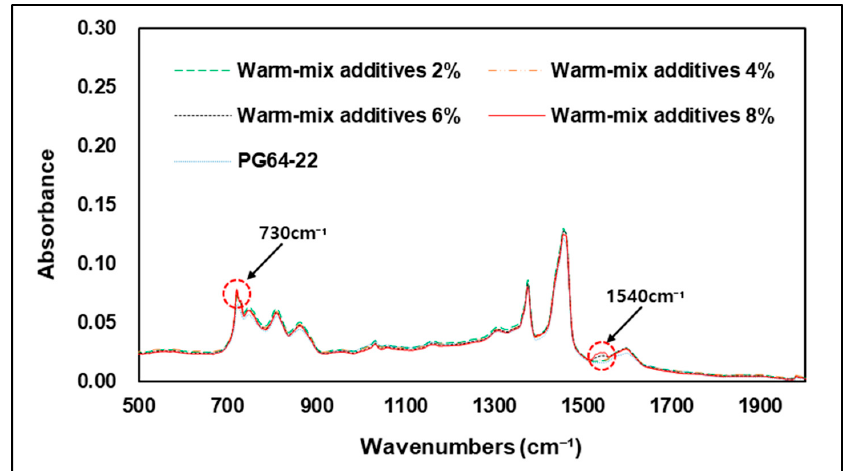
Figure 14. FTIR spectrum by warm-mix additives contents.